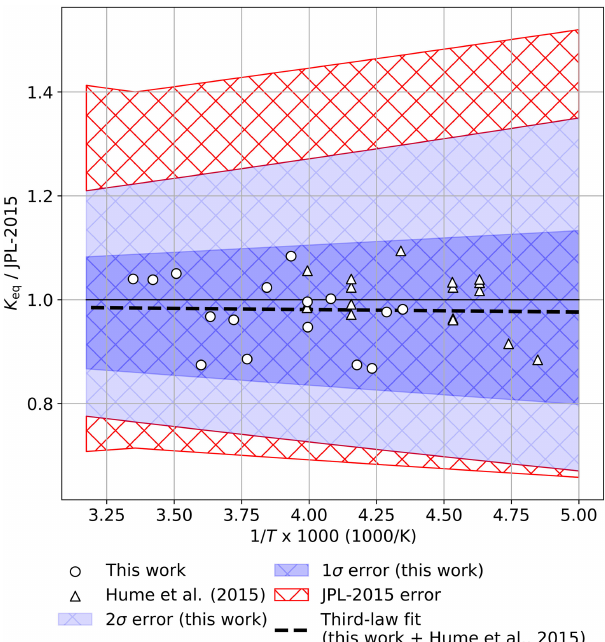
Figure 7. Ratio of a weighted third-law fit of K eq (black dashed line) determined from a combination of this work (circles) and Hume et al. (2015) (triangles) to the JPL compendium recom- mended value (Burkholder et al., 2015). For clarity, data points from this work are plotted as 3K averages of the full data set shown in Fig. 3. Error intervals as reported in this work (darker blue = 1 σ , lighter blue = 2 σ ) and as recommended by JPL-2015 (red cross